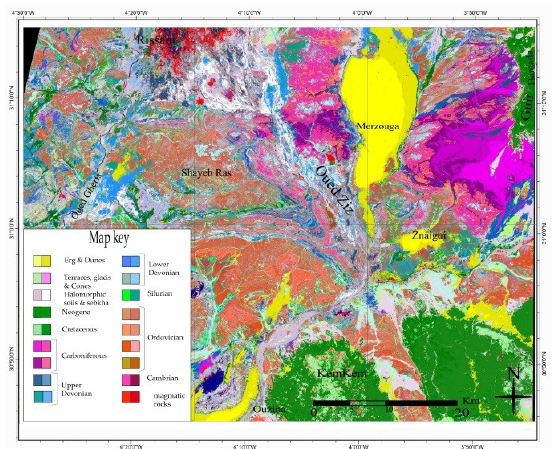
Figure 10: Spectral Angle Mapper classification image